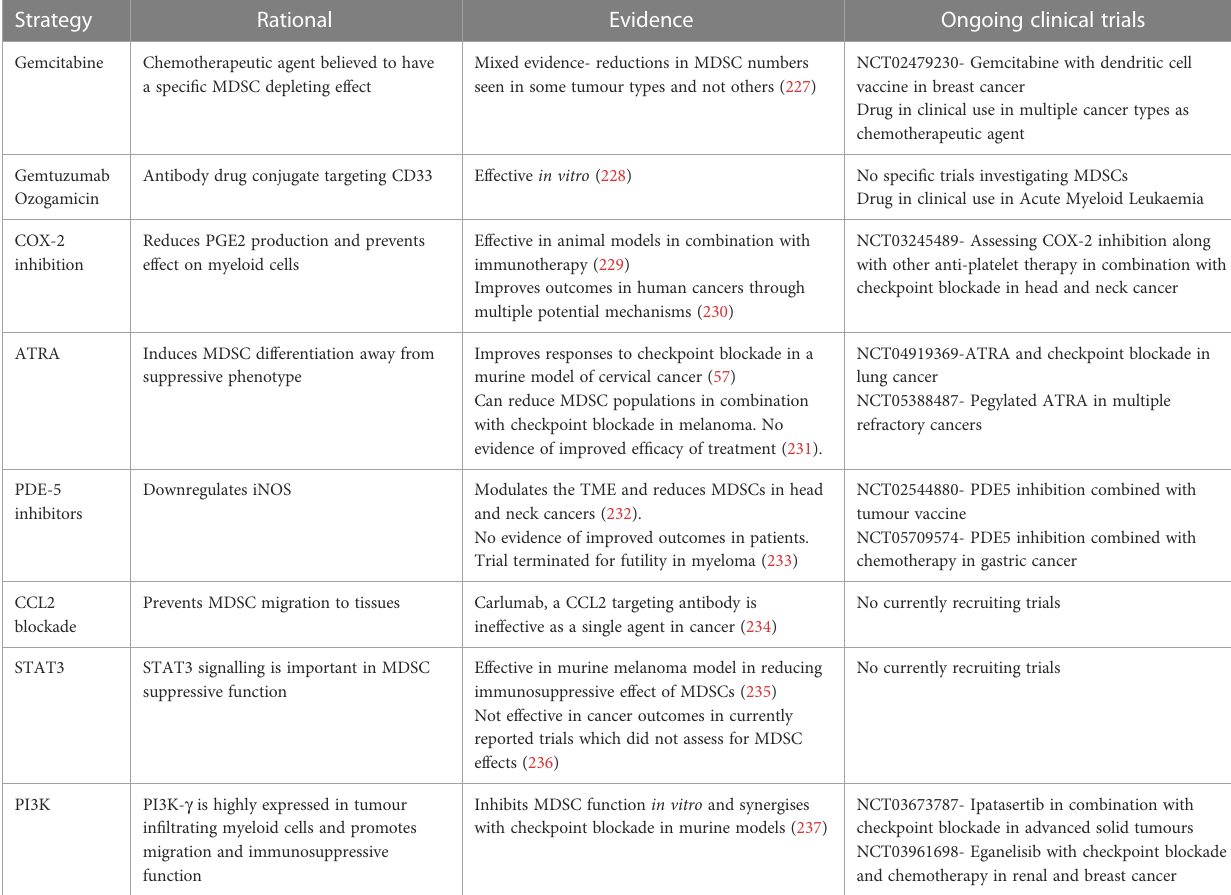
TABLE 2 Approaches to modulate MDSC populations in